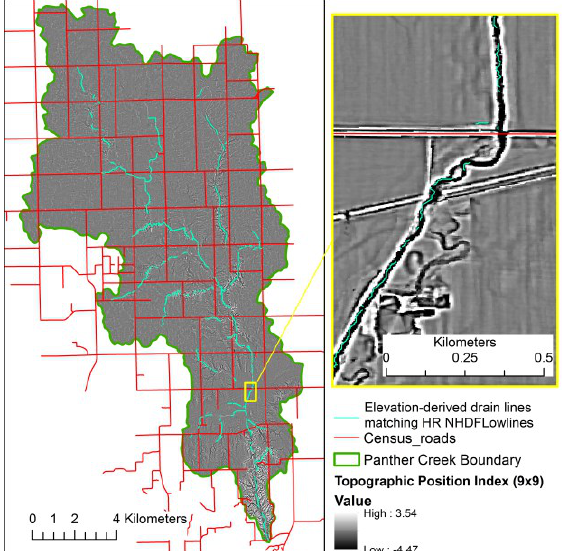
Figure 2. Topographic Position Index for the Panther Creek watershed. Census road lines are overlain in red. Drainage lines derived from 3-m resolution elevation data which match the high resolution NHD flowlines are overlain bright cyan.